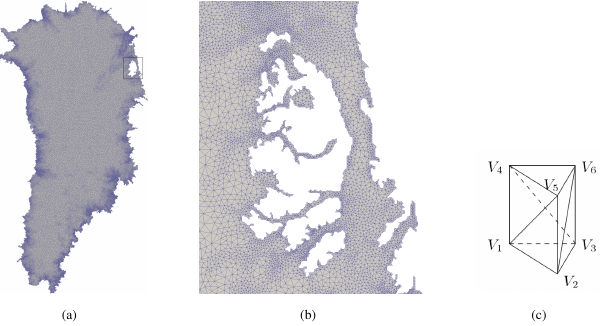
Figure 14. (a) Variable-resolution 1–7km GIS mesh, (b) close-up of the variable-resolution 1–7km GIS mesh (boxed region in a ), and (c) subdivision of the hexahedral finite element into three tetrahedra.